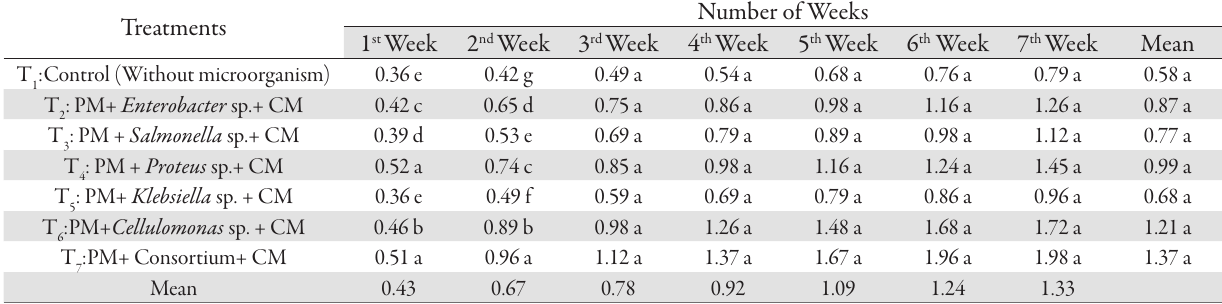
Tab. 5. Changes of Potassium percent during composting of press mud with cattle manure